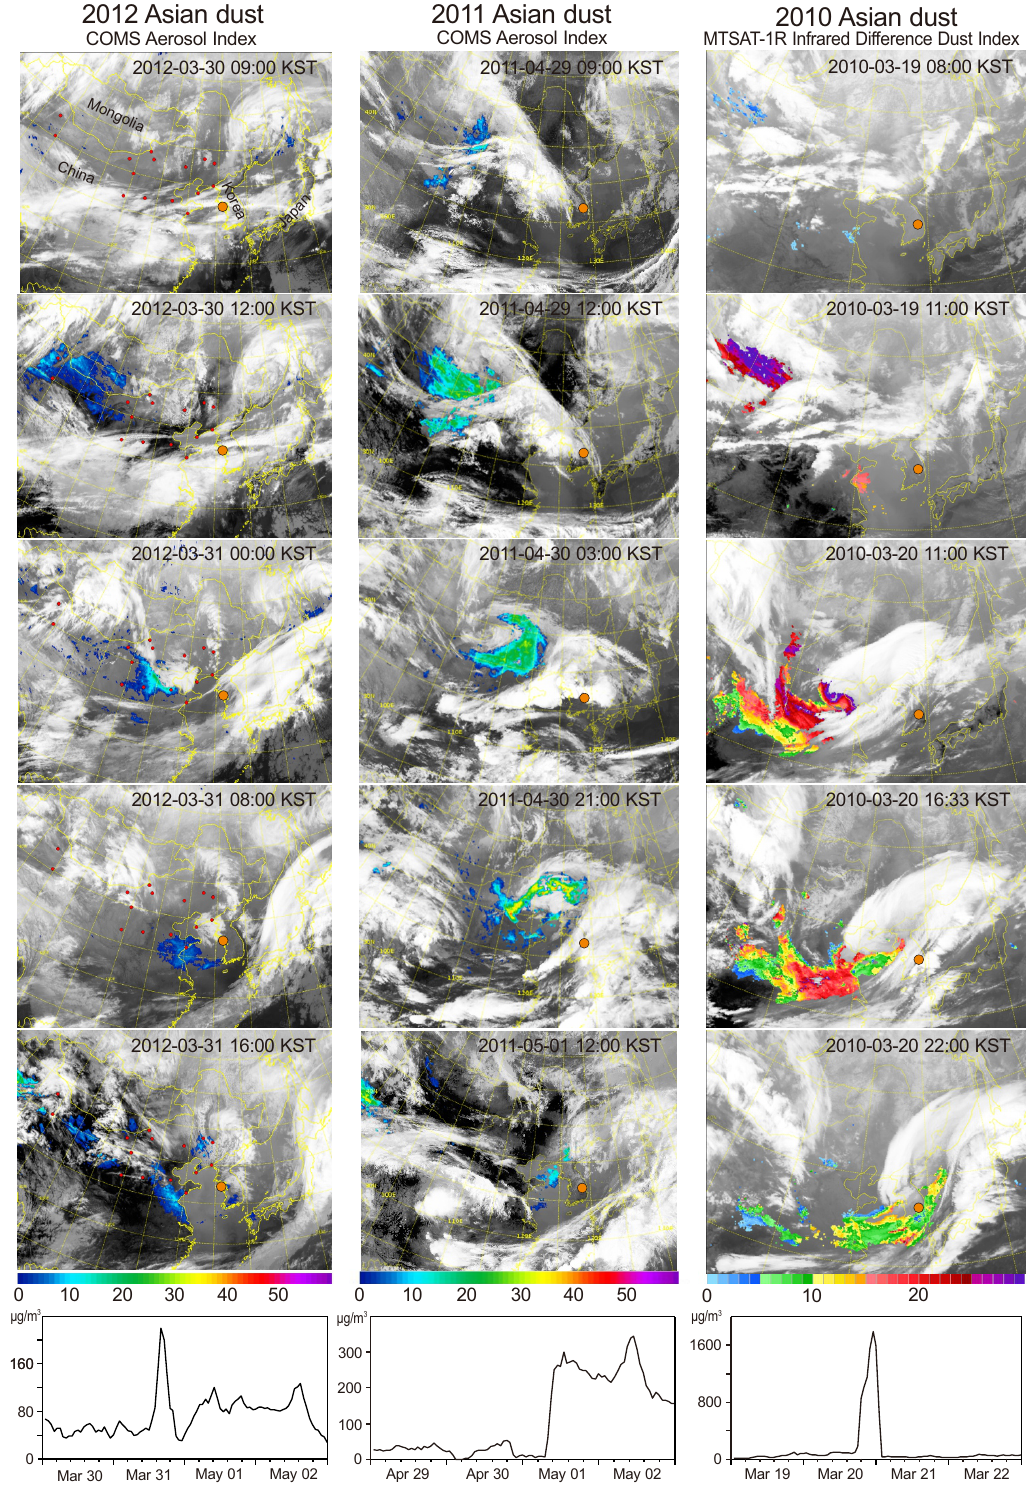
Fig. 1. COMS and MTSAT satellite images of the Asian dust index of three events observed in Korea. Solid orange circles are the TSP sampling sites in Korea. The graphs are plots of hourly PM 10 concentrations over 4 days in the Korea Meteorological Administration aerosol monitoring stations near sampling sites. Red dots in the 2012 COMS images are the stations of the Korea–China joint Asian dust monitoring